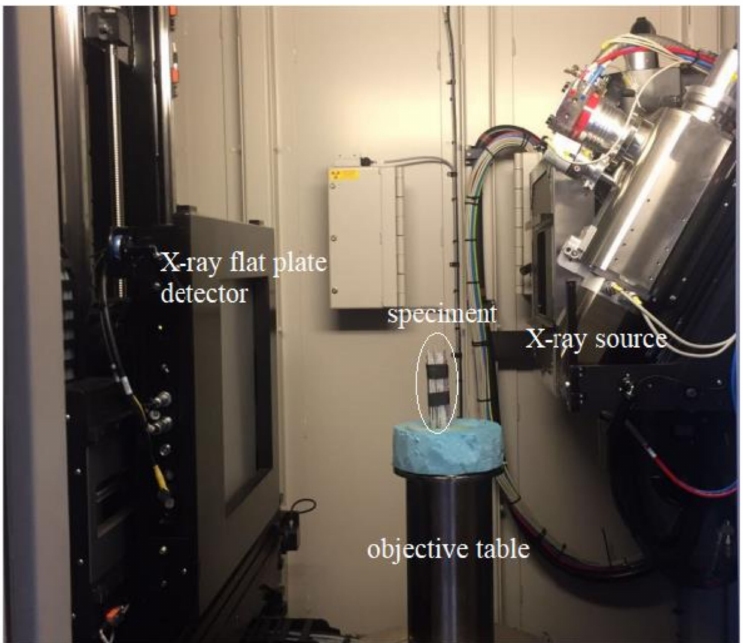
Figure 1. Sample to be scanned on industrial computed tomography (ICT)